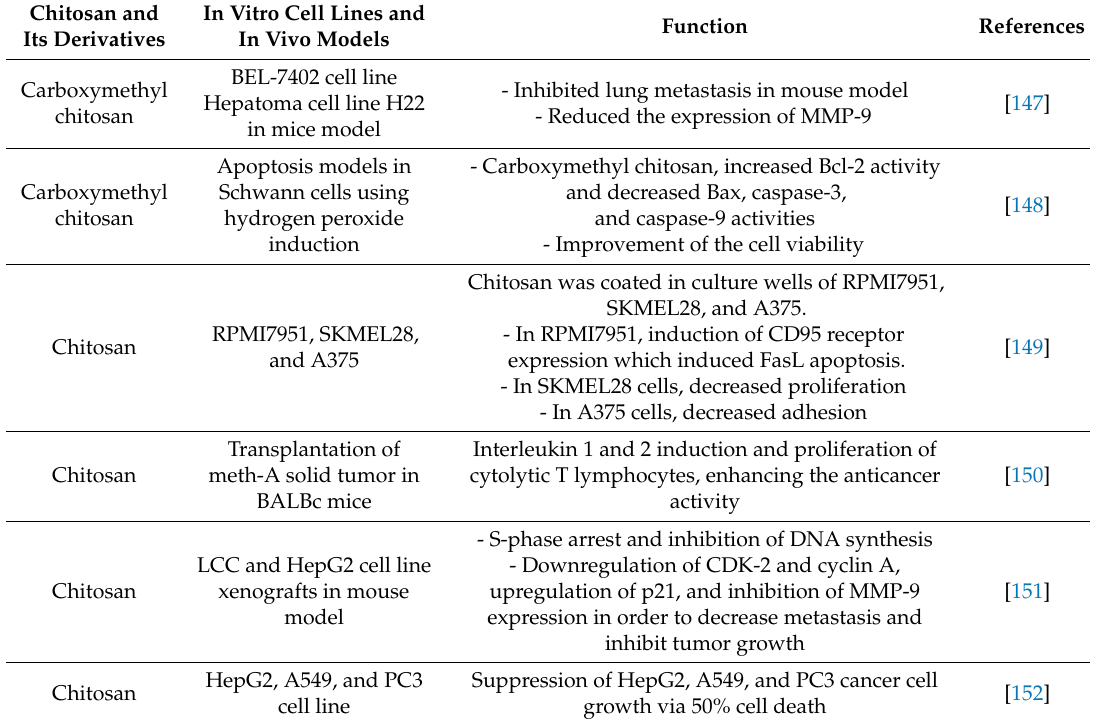
Table 2. A summary of Ch and its derivatives with their most important anticancer activities